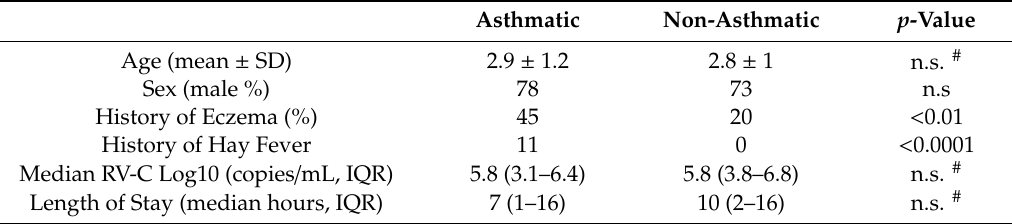
Table 1. Summary of clinical and demographic data of hospitalised children with RV-C-only respiratory wheeze ( n = 191).